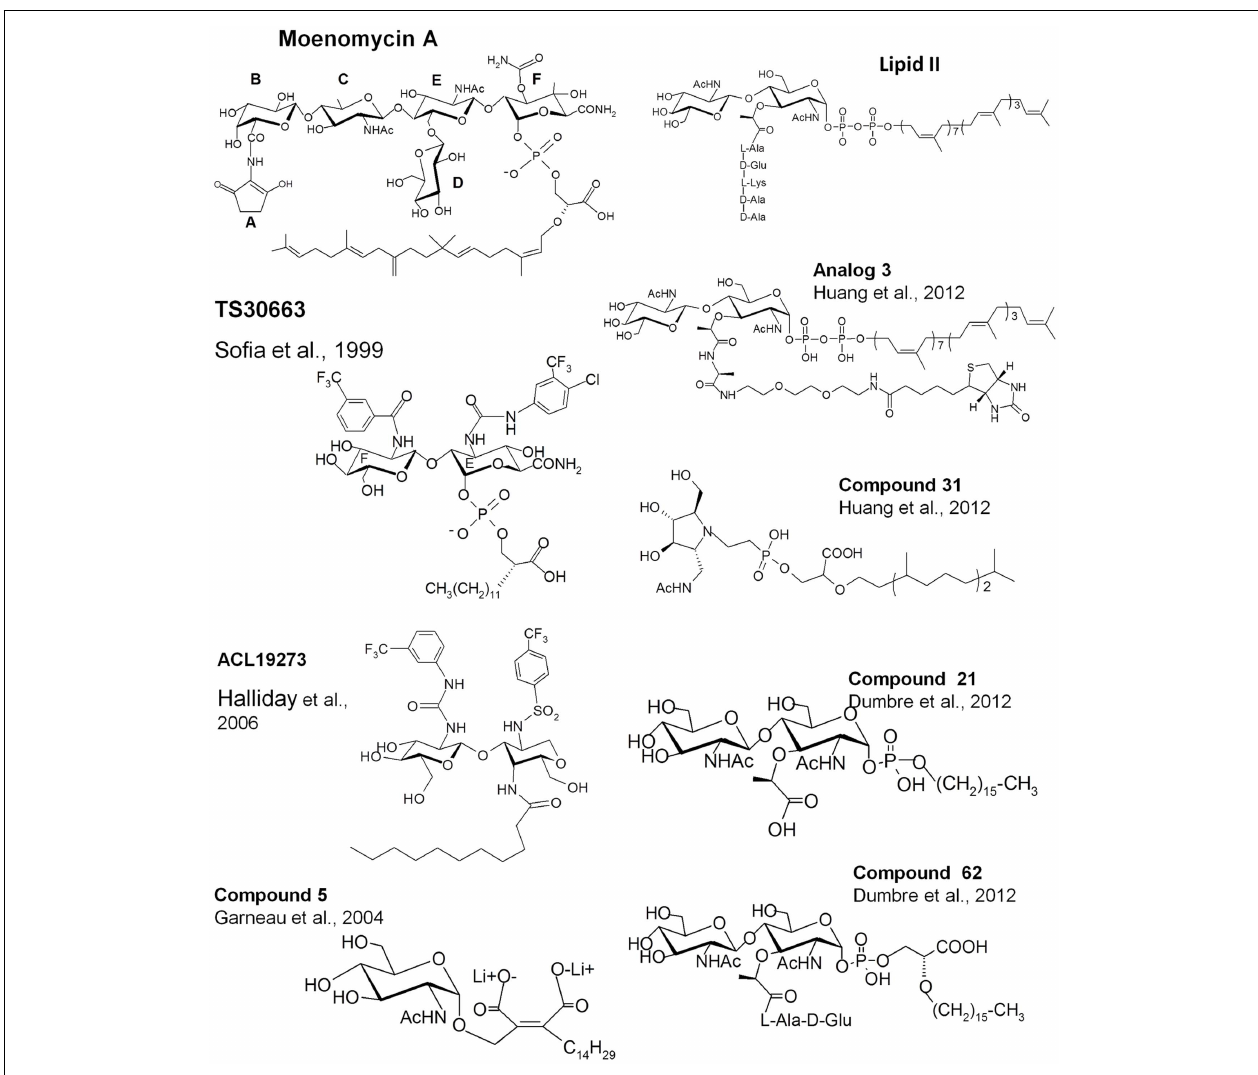
FIGURE 3 | Structures of lipid II, moenomycin, and their analogs. The names of the compounds are as in the original papers and are indicated with the